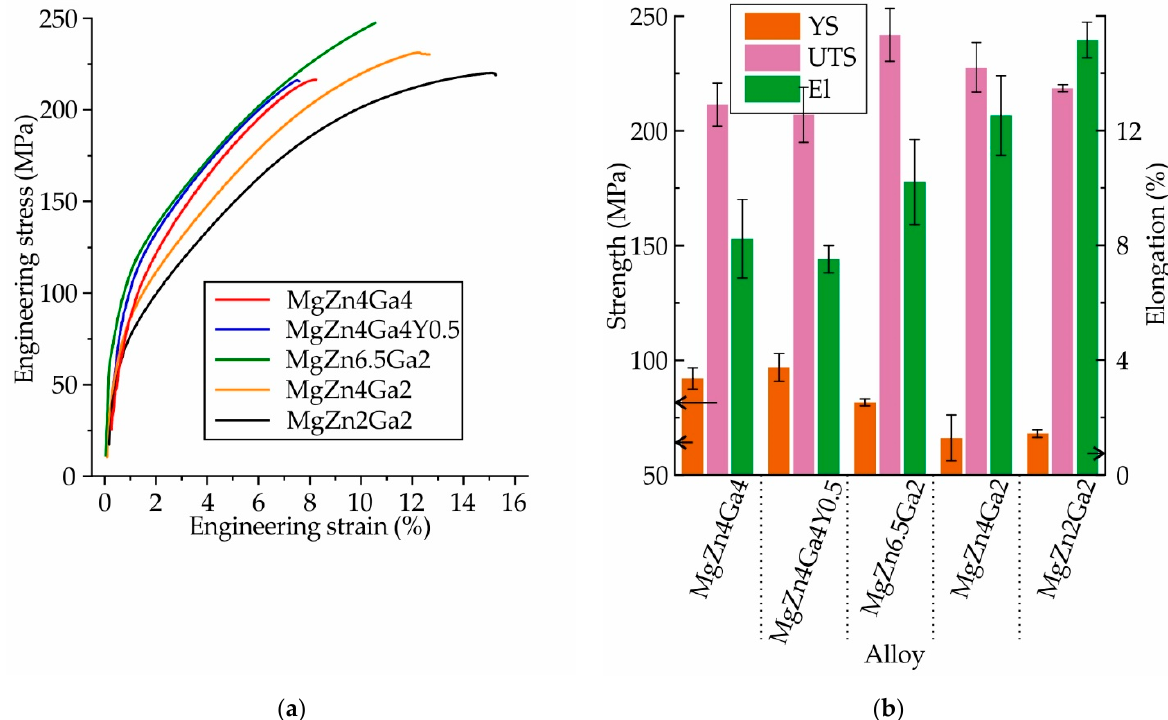
Figure 10. ( a ) Engineering stress–strain curves and ( b ) mechanical properties (YS: yield strength; UTS: ultimate tensile strength; and El: elongation at fracture) obtained during the tensile testing of the T4 heat-treated Mg–Zn–Ga alloys.